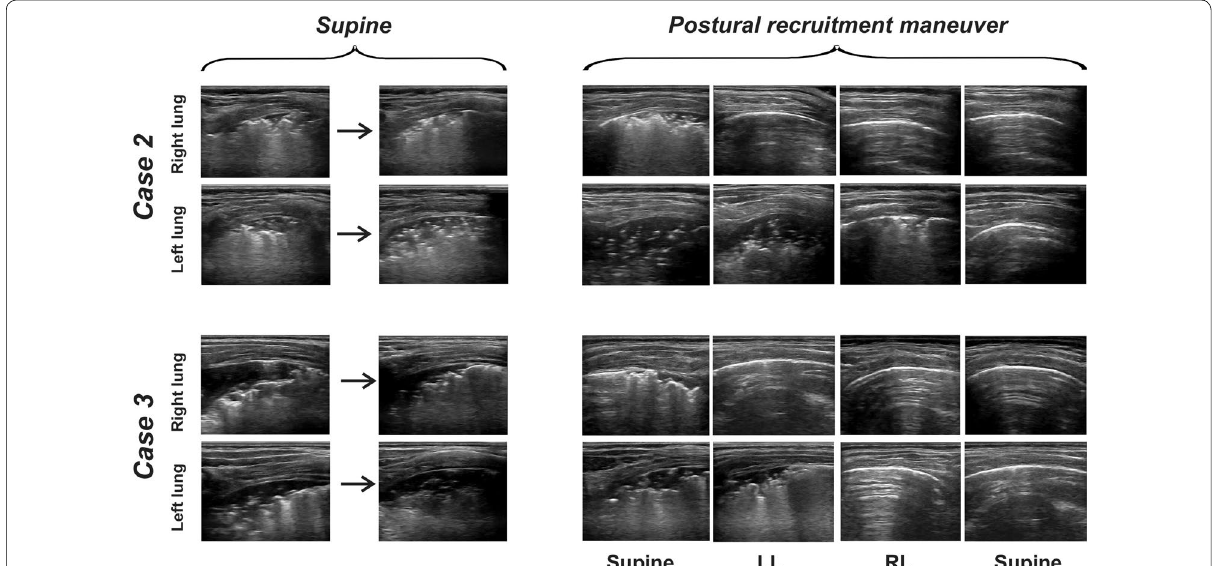
Fig. 3 Lung ultrasound images of postural recruitment in case 2 and